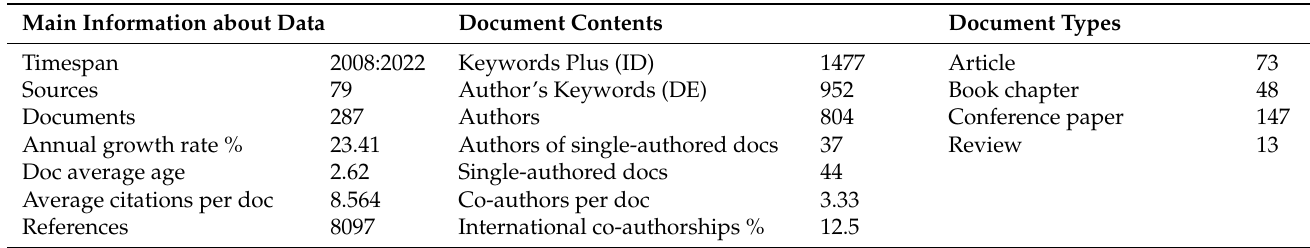
Table 2. Main information of Scopus’s publications.